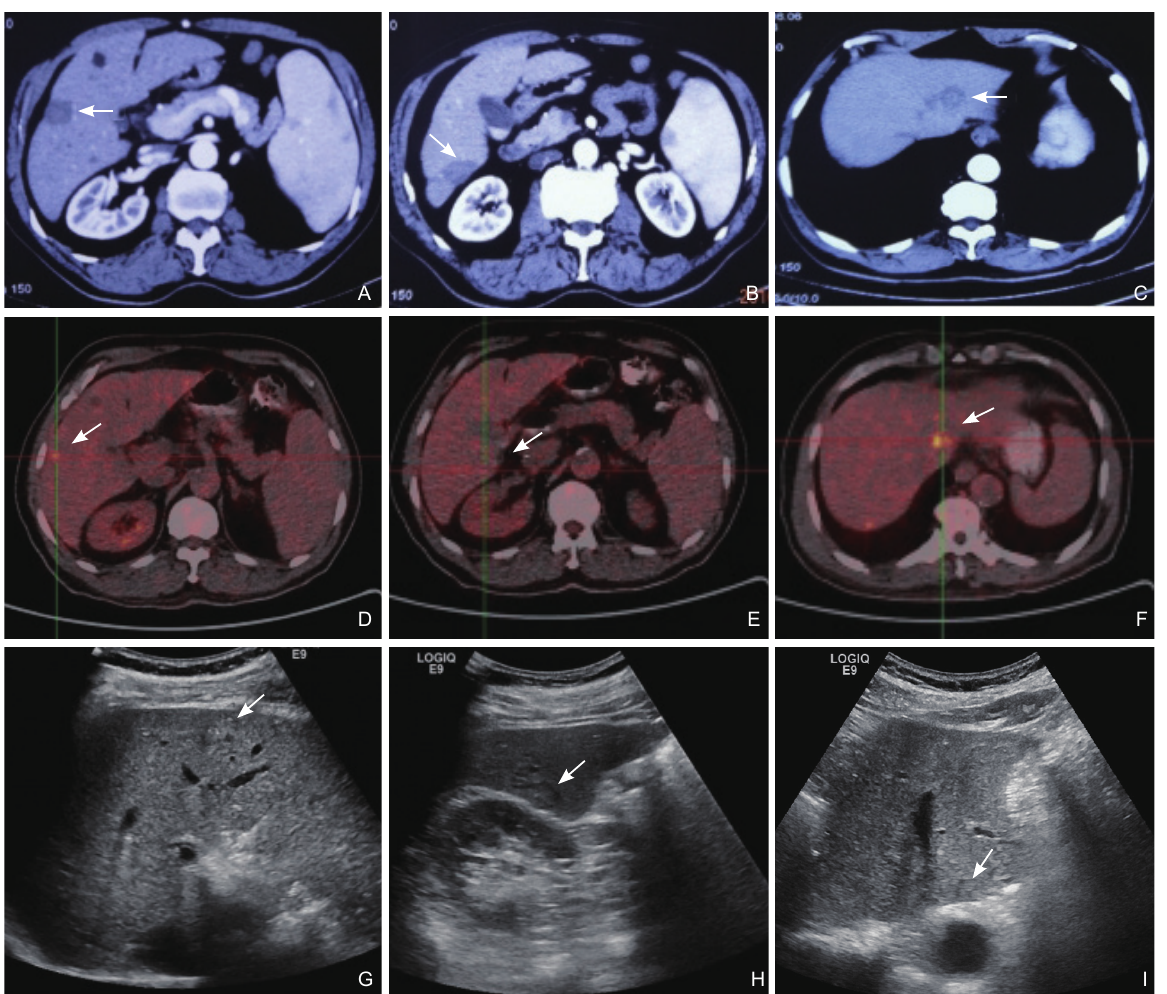
Figure 1 Liver computed tomography (CT), positron emission tomography/computed tomography (PET/CT), and ultrasound images from a 67-year- old male patient with colorectal liver metastases. Pre-ablation liver computed tomography revealed three low-density liver lesions in (A) the right anterior lobe near the liver surface, (B) the right posterior lobe, and (C) the left outer lobe are near the second hepatic gate. Pre-ablation liver positron emission tomography/computed tomography confirmed the three lesions (D, E, and F). Pre-ablation liver ultrasound images also identified the three lesions (G, H, and I). The arrows indicate the locations of the three